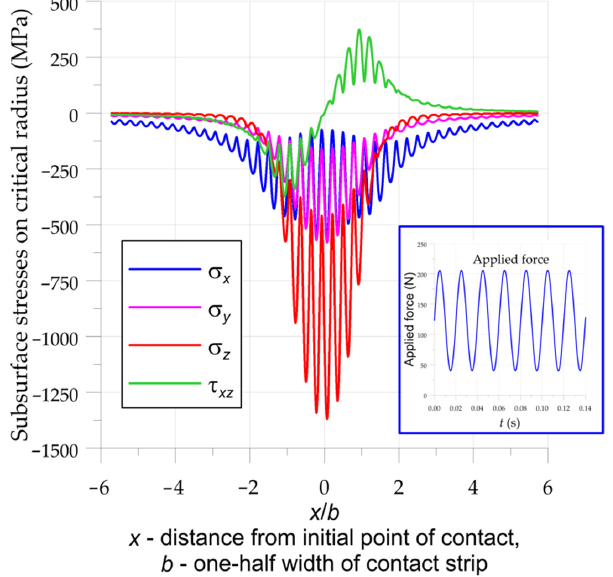
Figure 4. Subsurface stresses in the investigated cylindrical roller thrust bearing on critical radii in the bearing subjected to cyclic force (force acting on one roller: F m = 123 N, F a = 83 N). The identified non-zero stress components in the roller (i.e., the stress mean values σ x ,m , σ y ,m , σ z ,m , τ xz ,m ) and the stress amplitudes ( σ x ,a , σ y ,a , σ z ,a , τ xz ,a ) for primary and secondary cycles are shown in Table 3. The identification was done by application of the described direct spectral method, as discussed in Section 2.4. For the analyzed case, T B = T 1 and T 1 = 40· T 2 . T 1 is the time of contact of the roller. It should be noted, however, that due to the realistic distribution of stress in the roller, the base cycles for normal stress ( σ x , σ y , σ z ) have the form of pulsating compression with period T 1 , and the cycle for tangential stress ( τ xz ) has the form of a fully reversed type with period T 1 . Table 3. Identified mean values and amplitudes of stress components.